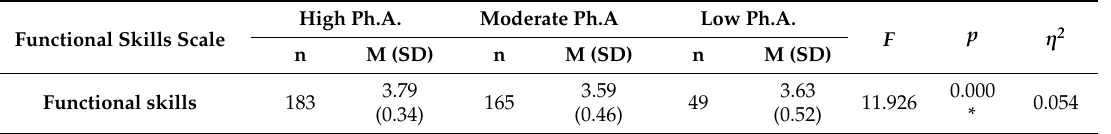
Table 2. Means, standard deviations and one-way ANOVA of the participant scores in the functional skills scale (CUBRECAVI) according to their level of physical activity. High Ph.A. Moderate Ph.A Low Ph.A. Functional Skills Scale M (SD) n M (SD) Functional skills 183